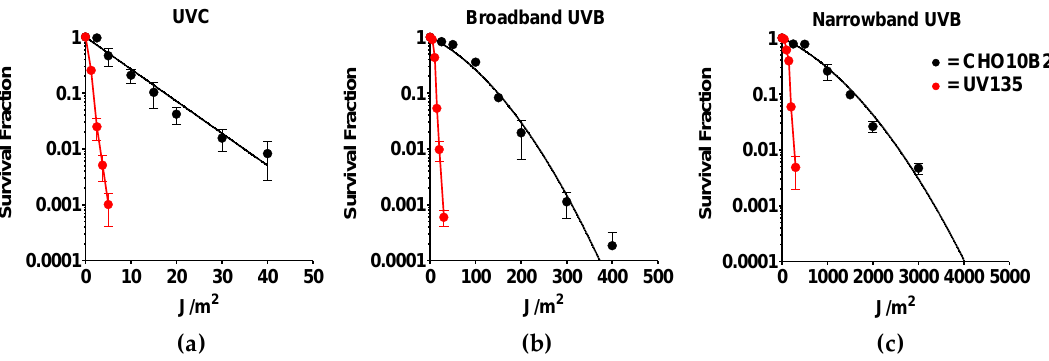
Figure 2. UV exposure cell survival curves. ( a ) Ultraviolet C (UVC)-exposed cells; ( b ) Broadband UVB (BB-UVB)-exposed cells; ( c ) Narrowband UVB (NB-UVB)-exposed cells. Black circles indicate wildtype CHO10B2 cells. Red circles indicate XPG mutant UV135 cells. Error bars indicate standard errors of the means from as many as three independent experiments. Table 1. D 10 values (dose required to kill 90% of cells) of ultraviolet radiation (UVR). UVR Source D 10 Value by Cell Type (J / m 2